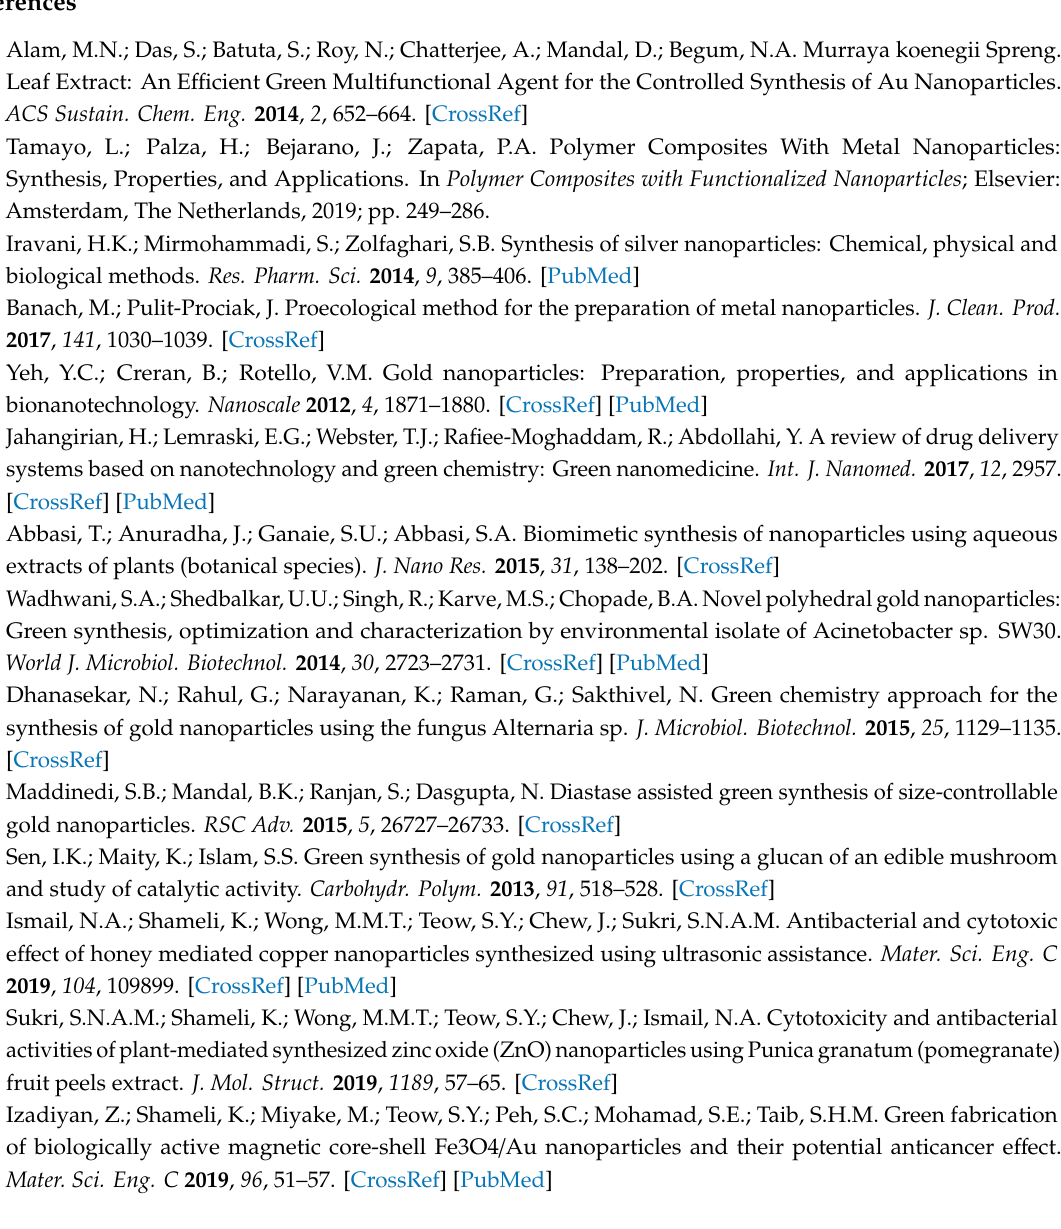
Figure S1: A comparison of UV-vis spectrum between PCA and AgPCA. Figure S2: Drug release profile of PCA and AgPCA at the first